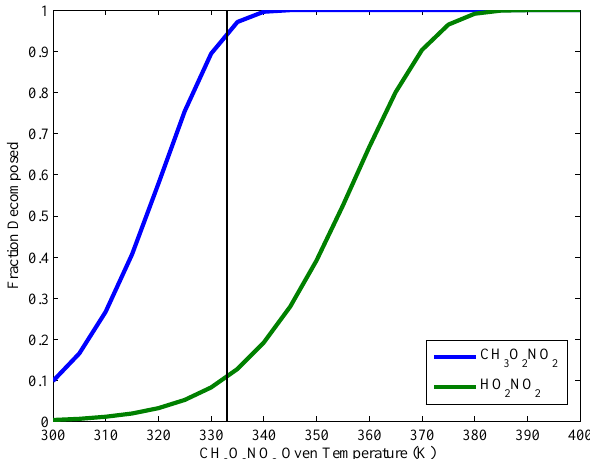
Figure 4. The calculated fractional decomposition of CH3O2NO2 (blue) and HO2NO2 (green) as a function of CH 3 O 2 NO 2 oven tem- peratures at a pressure of 230 hPa and a residence time of 0.08s. The black line marks the target temperature ( ∼ 60 ◦ C) for optimal sep- aration of CH 3 O 2 NO 2 and HO 2 NO 2 . Rates used to calculate the fraction decomposition are shown in Table